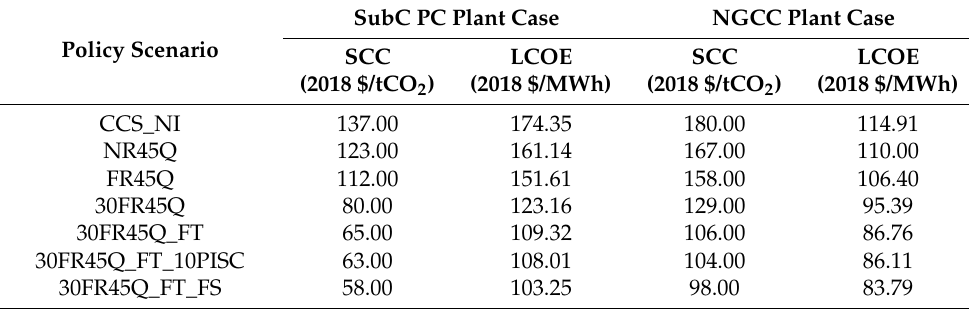
Table 2. Transition points to economically efficient CCS implementation given prevailing SCC value and policy